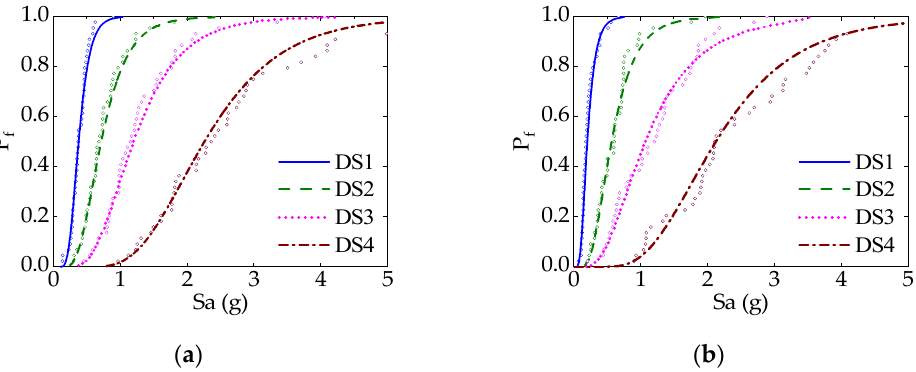
Figure 9. The fragility curves of the two structures: ( a ) 4-story; ( b ) 8-story. The probability of the two structures reaching DS1 was 79% and 97%, respectively, when Sa was 0.5 g. Meanwhile, the probability of the two structures reaching DS2 was 20% and 40%, respectively, when Sa was 0.5 g. The probability of the two structures reach-